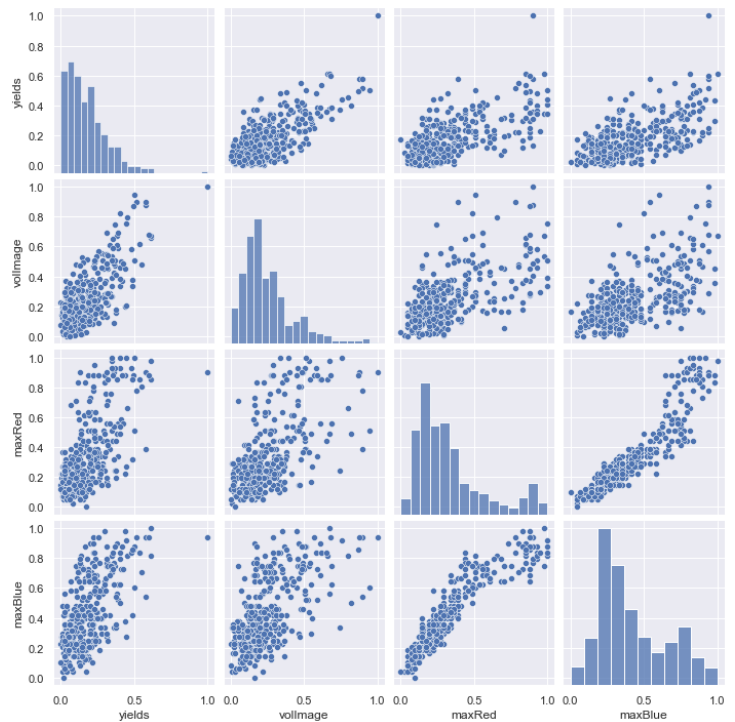
Figure 15. Scatter plot of crop yield, volume, maxRed, and